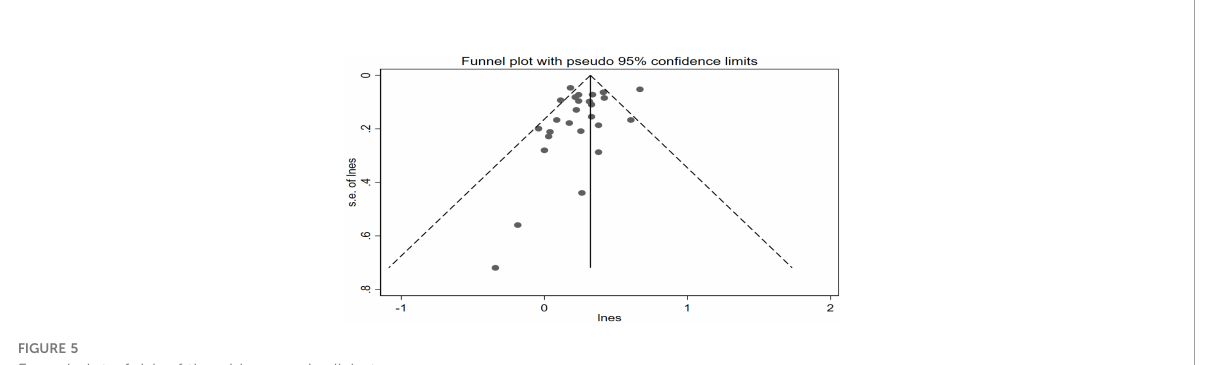
FIGURE 5 Funnel plot of risk of thyroid cancer in